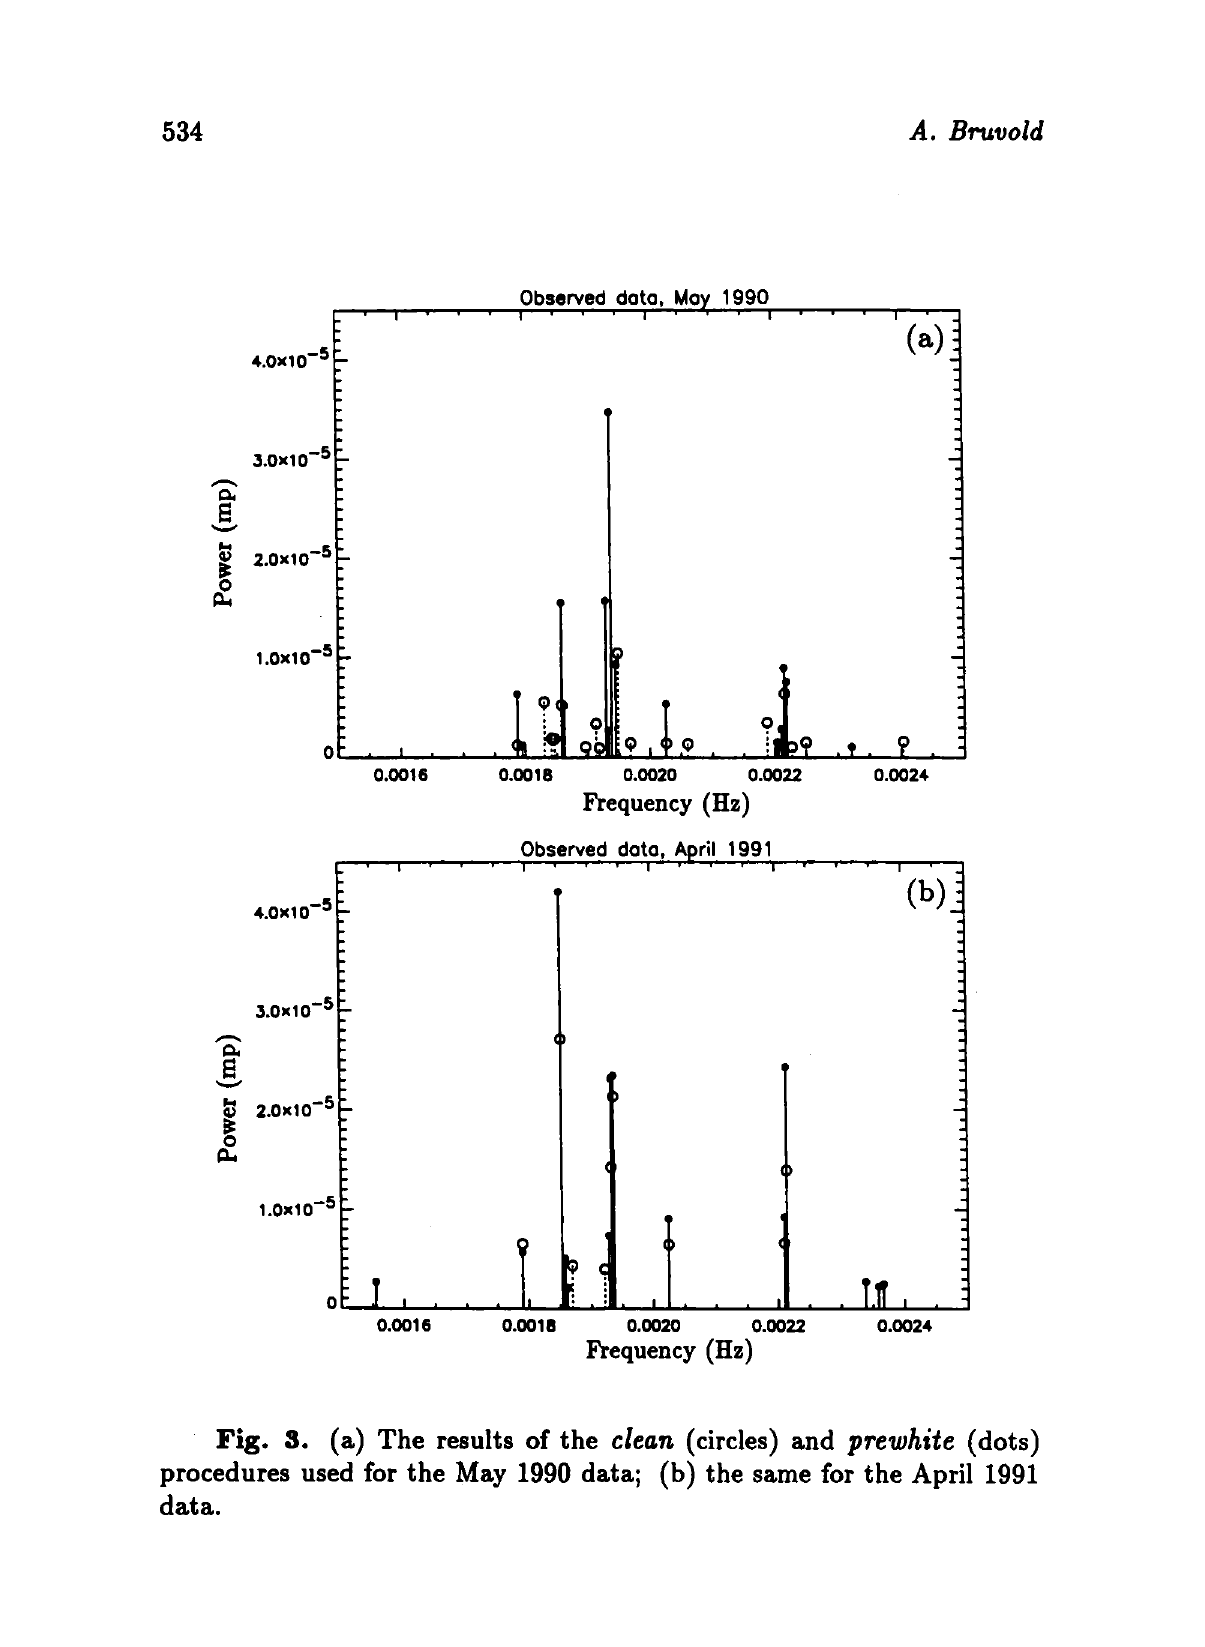
Fig. 3. (a) The results of the clean (circles) and prewhite (dots) procedures used for the May 1990 data; (b) the same for the April 1991